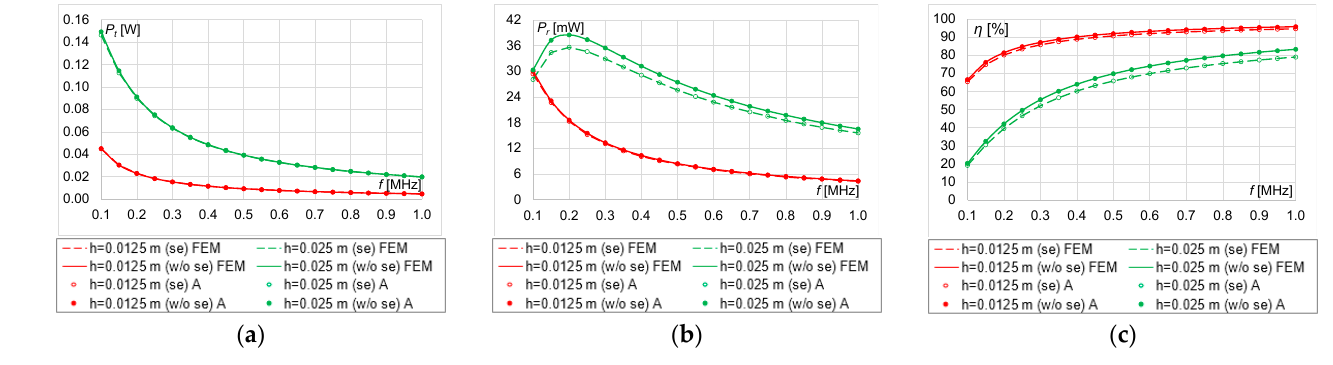
Figure 14. Results for n = 70 for the cases with and without skin effect: ( a ) P t , ( b ) P r , ( c ) η . The P t power decreases over the entire frequency range, regardless of n and h (Figures 12a, 13a and 14a). The transmitter power is always higher at h = 0.025 m, regardless of n . The greatest difference in values occurs in the lower frequency range. The P t power is the same for the cases with and without skin effect at all